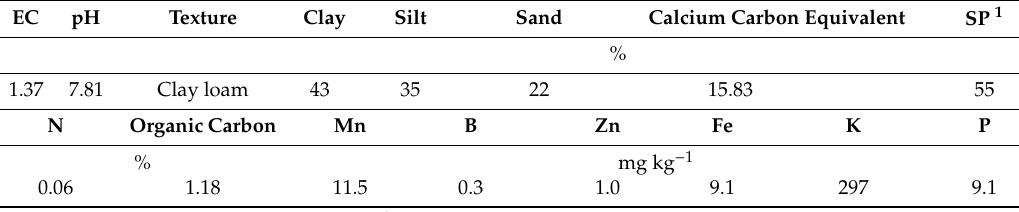
Table 1. Some physico-chemical properties of soil in the studied region.